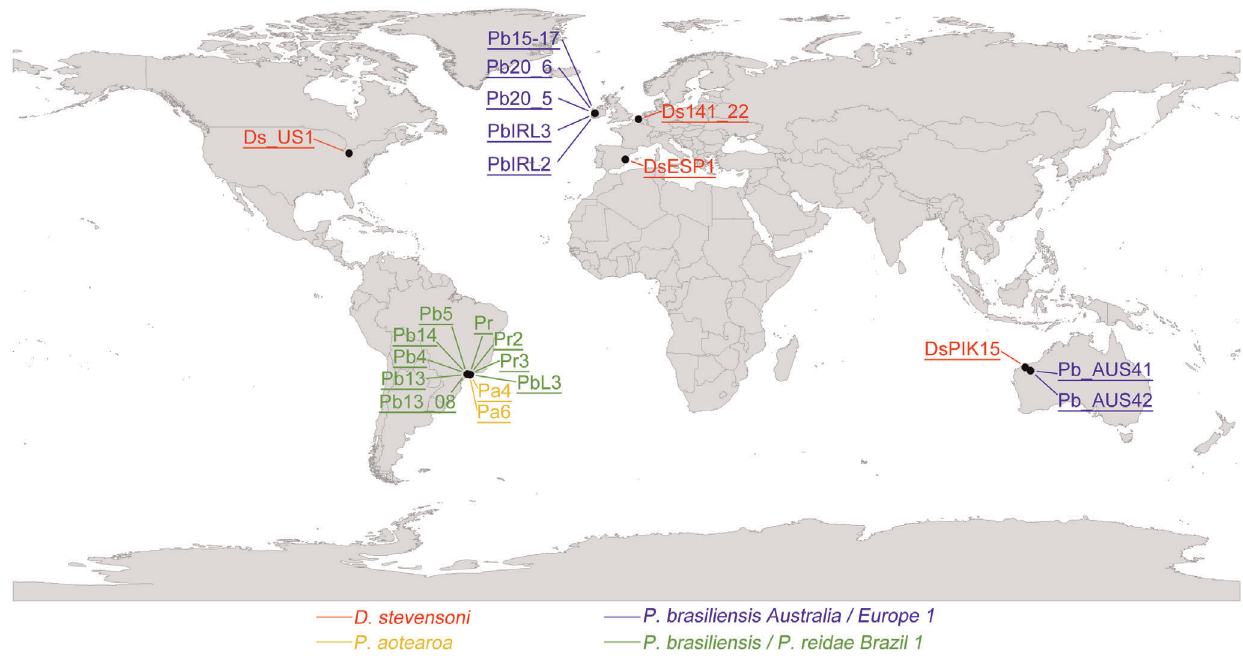
Figure 4. Global distribution of the EG species, determined by ITS2 sequence data. Letters and numbers in the map refer to the analyzed specimens (see Table S2 for more details). Different EG species are indicated by different color codes.